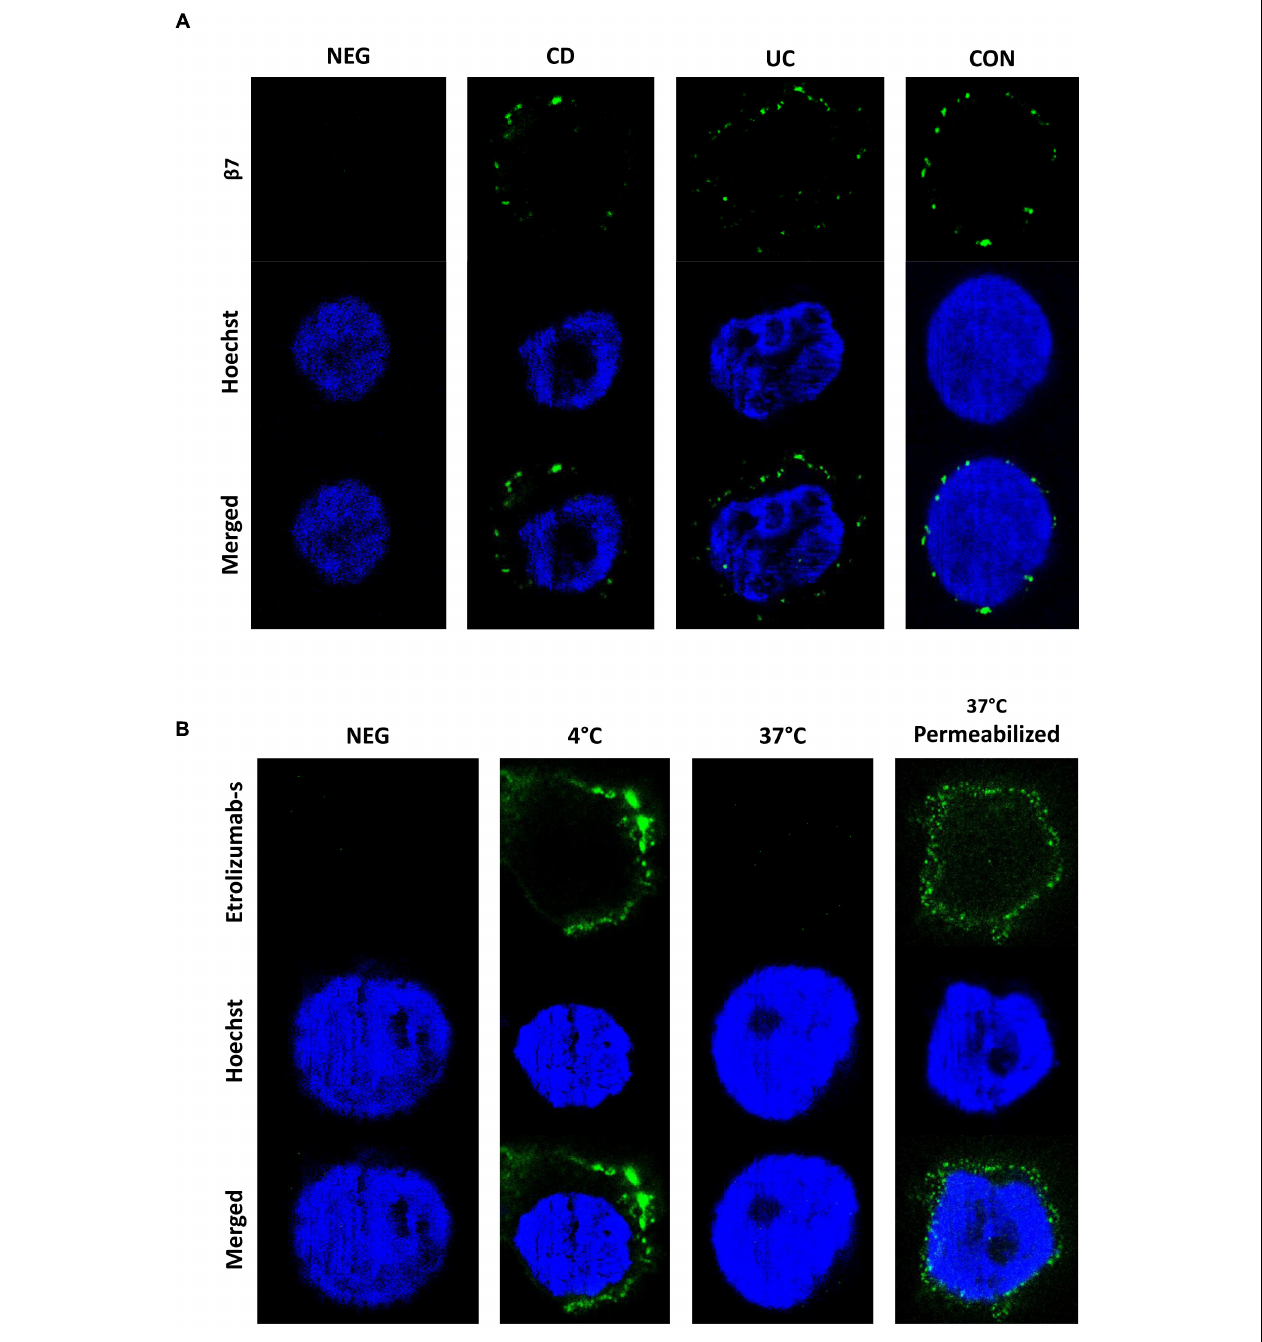
FIGURE 3 | Assessment of etrolizumab-s internalization by STED microscopy. (A) Representative STED microscopy images showing localization and distribution of β 7 integrin on the surface of cells from CD, UC, and CON donors. Additionally, a negative control (NEG) without primary antibody staining is shown. Images are representative for seven independent experiments. (B) Representative images showing etrolizumab-s localization on/in cells incubated with etrolizumab-s at 4 ◦ C or cells incubated with etrolizumab-s at 37 ◦ C and additionally treated with or without Triton-X. Additionally, a negative control without primary antibody staining is shown. Images are representative for five independent